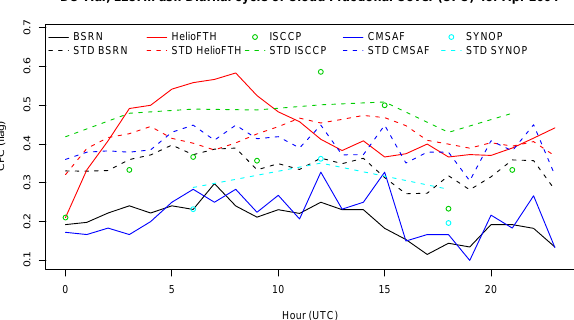
Fig. 3. Mean diurnal cycle of CFC and its standard deviation (STD) for BSRN sites for April 2004.